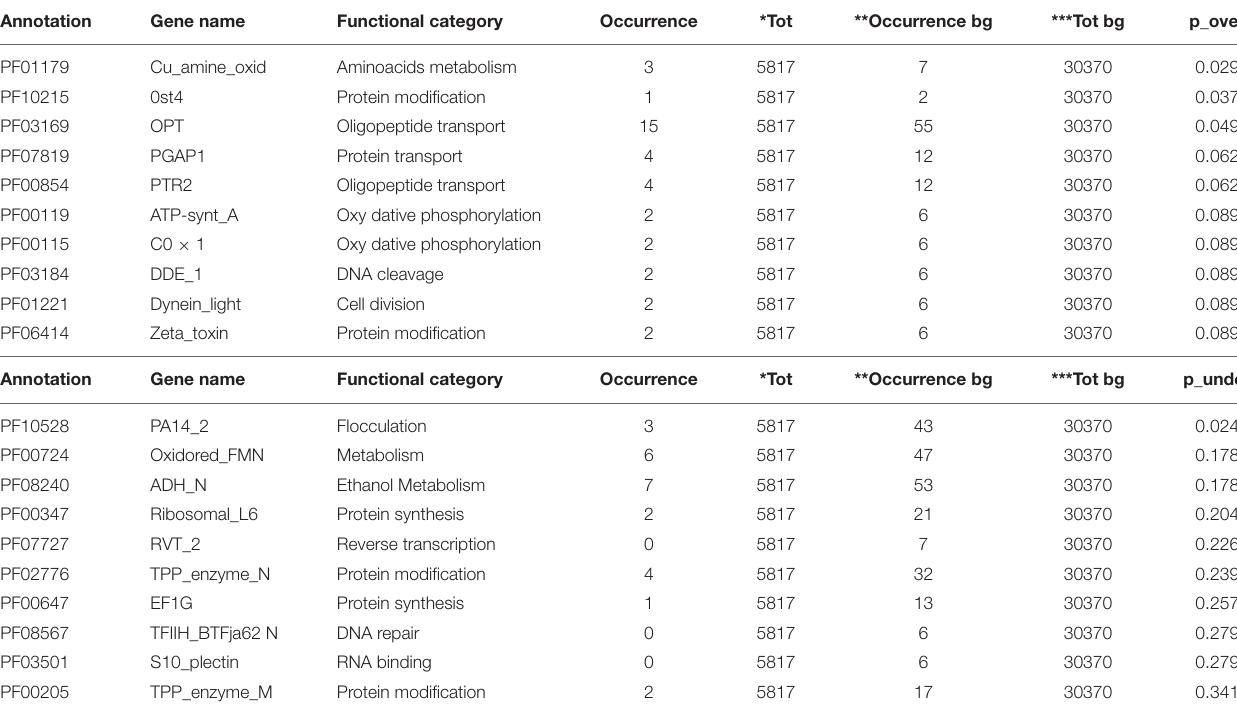
TABLE 6 | The top 10 enriched and under-represented domains of H4